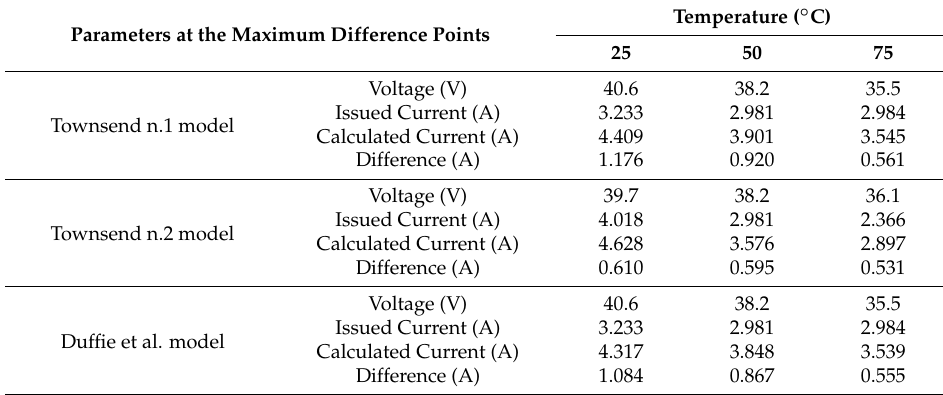
Table 10. Maximum current differences between the calculated and the issued I-V characteristics of Sanyo HIT-240 HDE4, at irradiance G = 1000 W/m 2